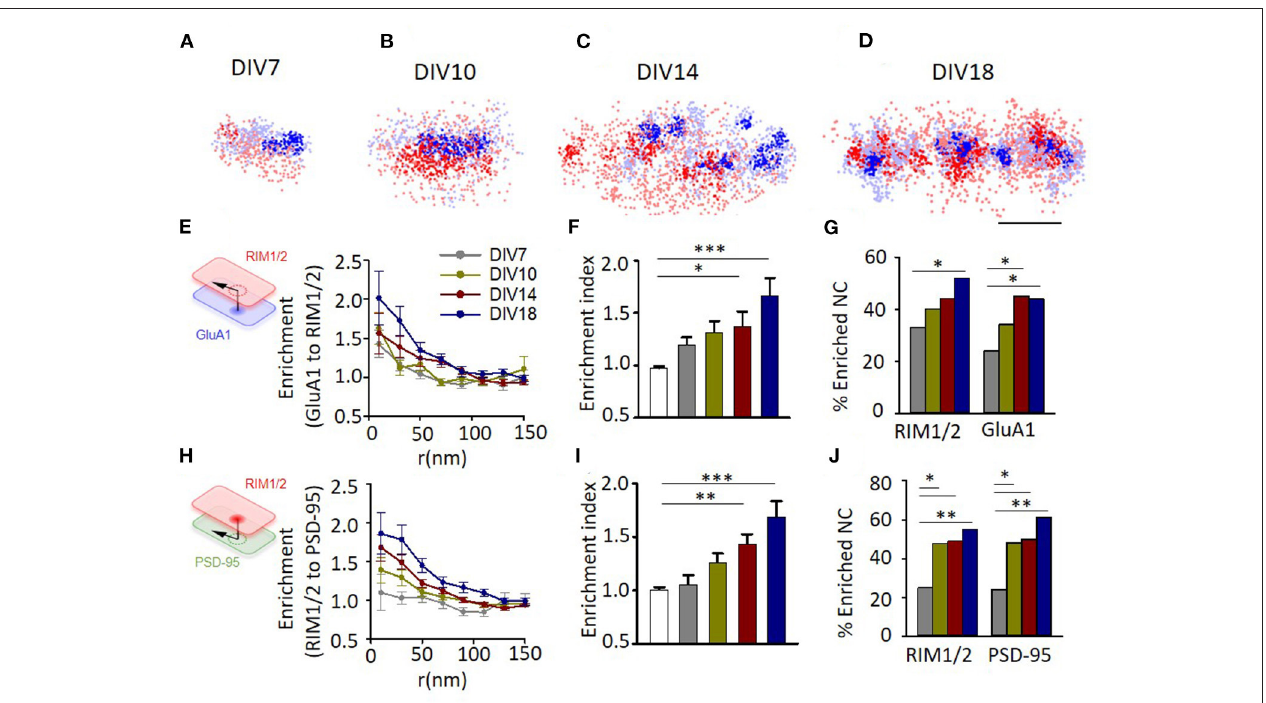
FIGURE 4 | Evolvement of trans-synaptic nano-alignment during synaptic maturation. (A–D) Representative examples of synapses with RIM1/2 (red) and GluA1 (blue) co-labeled and imaged with STORM. Thick color denotes detected nanoclusters. Scale bar, 200nm. (E) Normalized local density of GluA1 along with distances from RIM1/2 nanoclusters for synapses at different developmental stages. (F) , Averaged enrichment of GluA1 within 50nm from peaks of RIM1/2 nanoclusters ( n = 85, 60, 30, 54, and 54 nanoclusters). The open bar represents the enrichment indices of synapses with the position of nanoclusters randomized within synaptic clusters. (G) Fraction of nanoclusters that were enriched with protein across the cleft. (H–J) Enrichment between RIM1/2 and PSD-95 for synapses at different developmental stages. * p < 0.05, ** p < 0.01, *** p < 0.001, one-way ANOVA with Tukey’s multiple comparisons test in (F,I) , z -test in (G,J) . Also refer to Supplementary Table 1 for more statistical details. All experiments were repeated ≥ 3